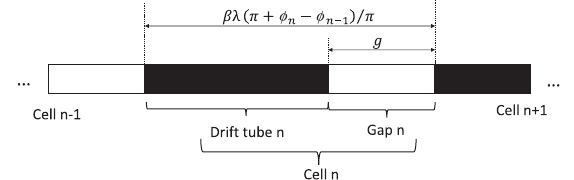
FIG. 2. Cell arrangement in accordance with synchronous